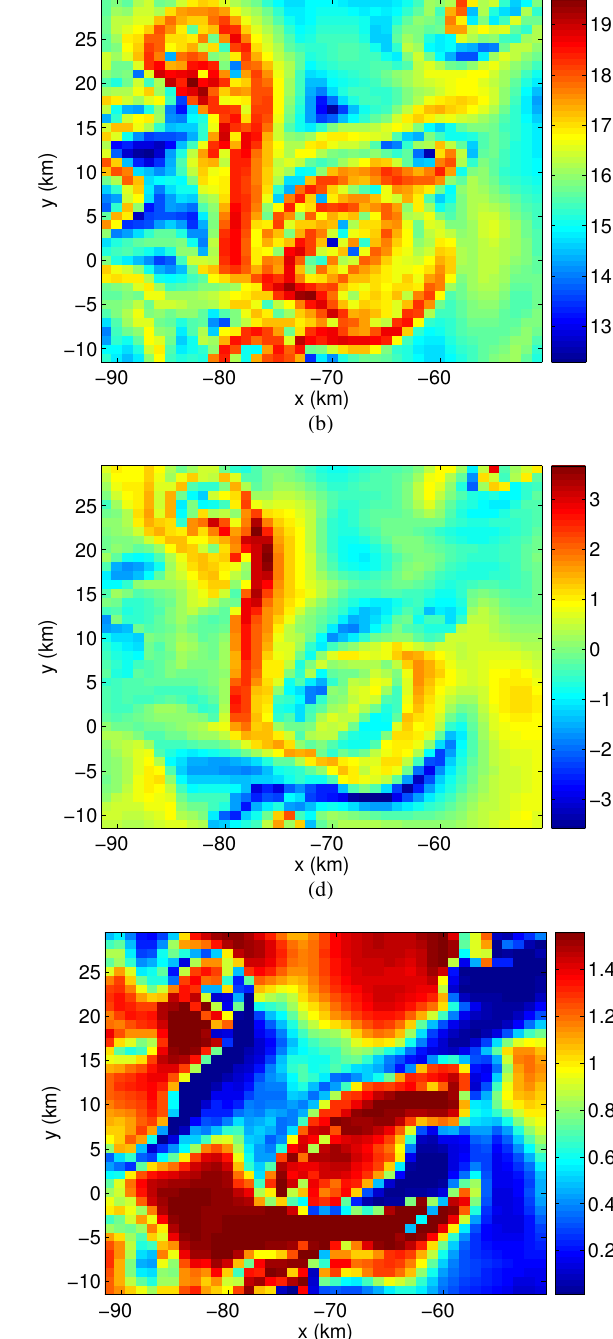
defined by where c is constant. The “planar” FTLE resolves ridges much